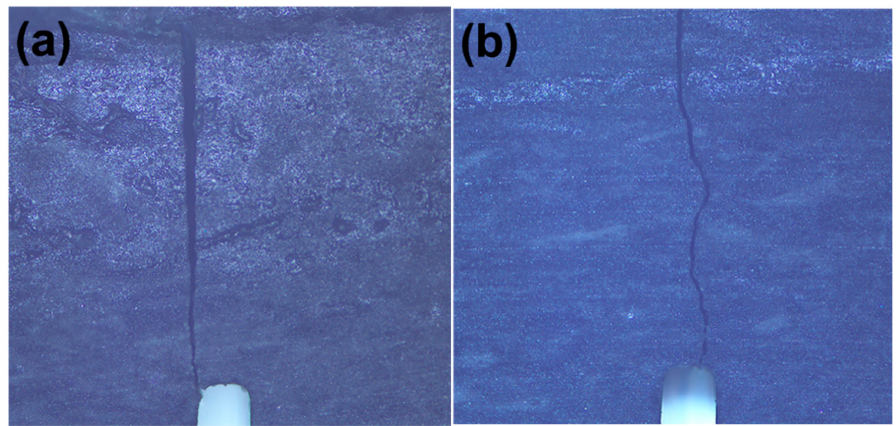
Figure 9. Optical images of crack path, ( a ) S1; ( b )